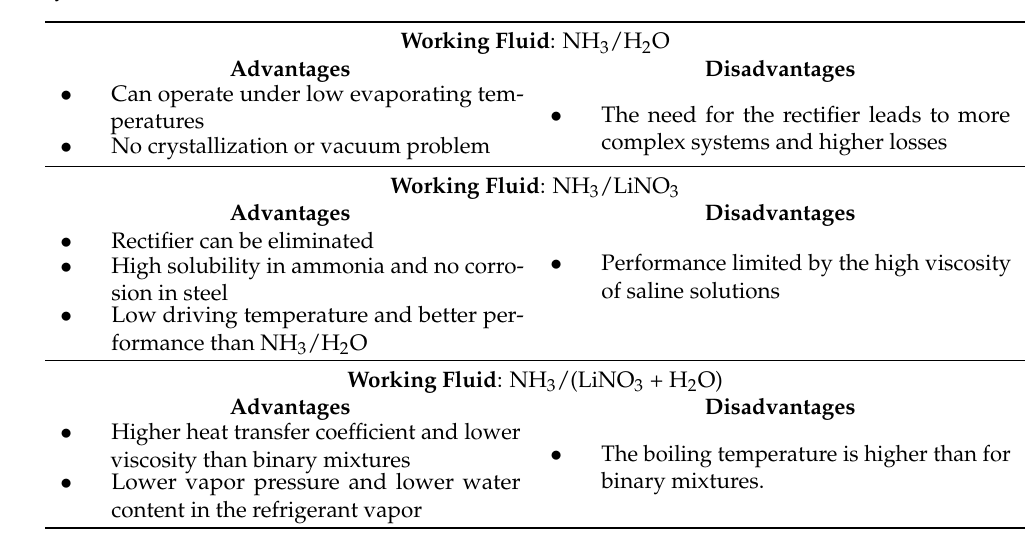
Table 4. Advantages and disadvantages of ammonia/absorbent working fluids for absorption